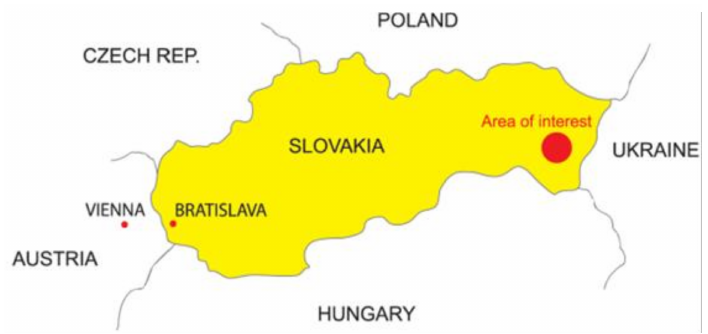
Figure 2. Map of the area of